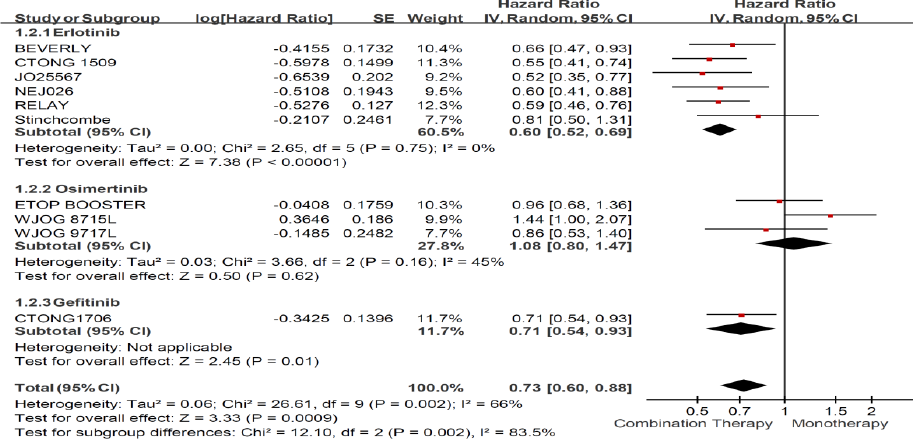
Figure A1. Forest plot and pooled hazard ratio for PFS.